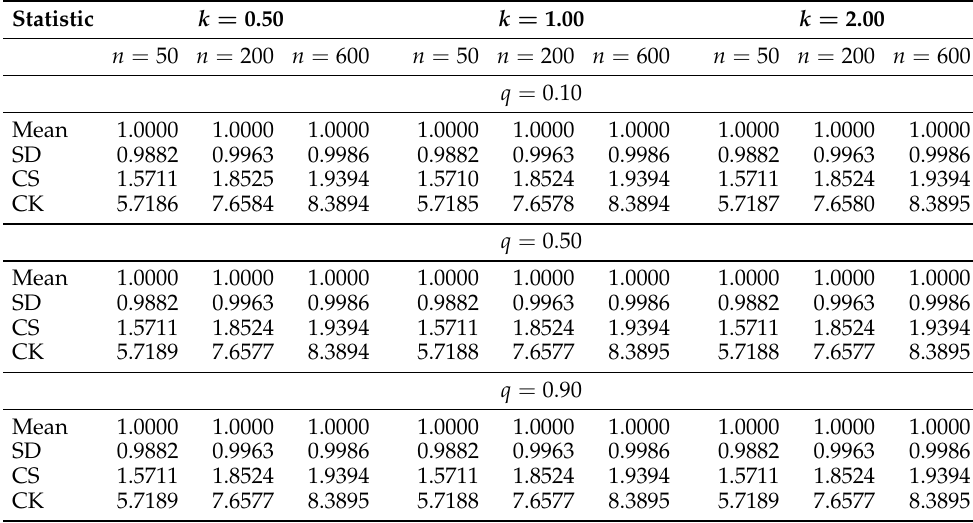
Table 8. Summary statistics of the GCS residuals ( β 0 = 0.5; β 1 =